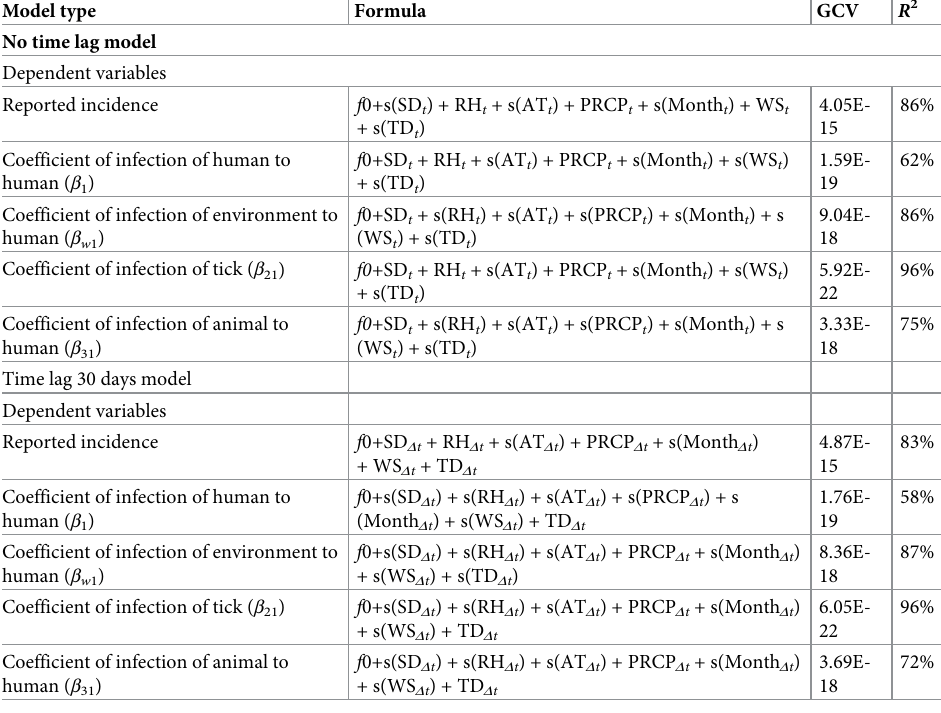
Table 3. Optimal generalized additive models built with time lags and non-time